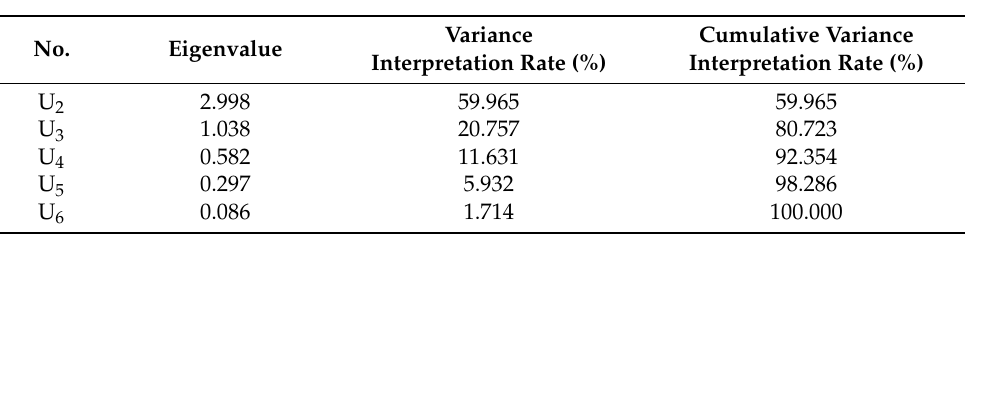
Table 6. Principal component variance interpretation of tomato quality indicators under each